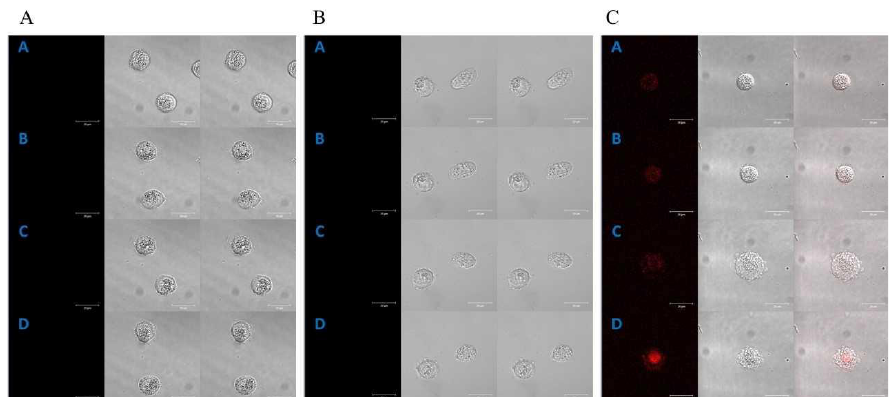
Figure 1. Control of the localization of porphyrins in the HT29 cell line ( A ); selected images received at